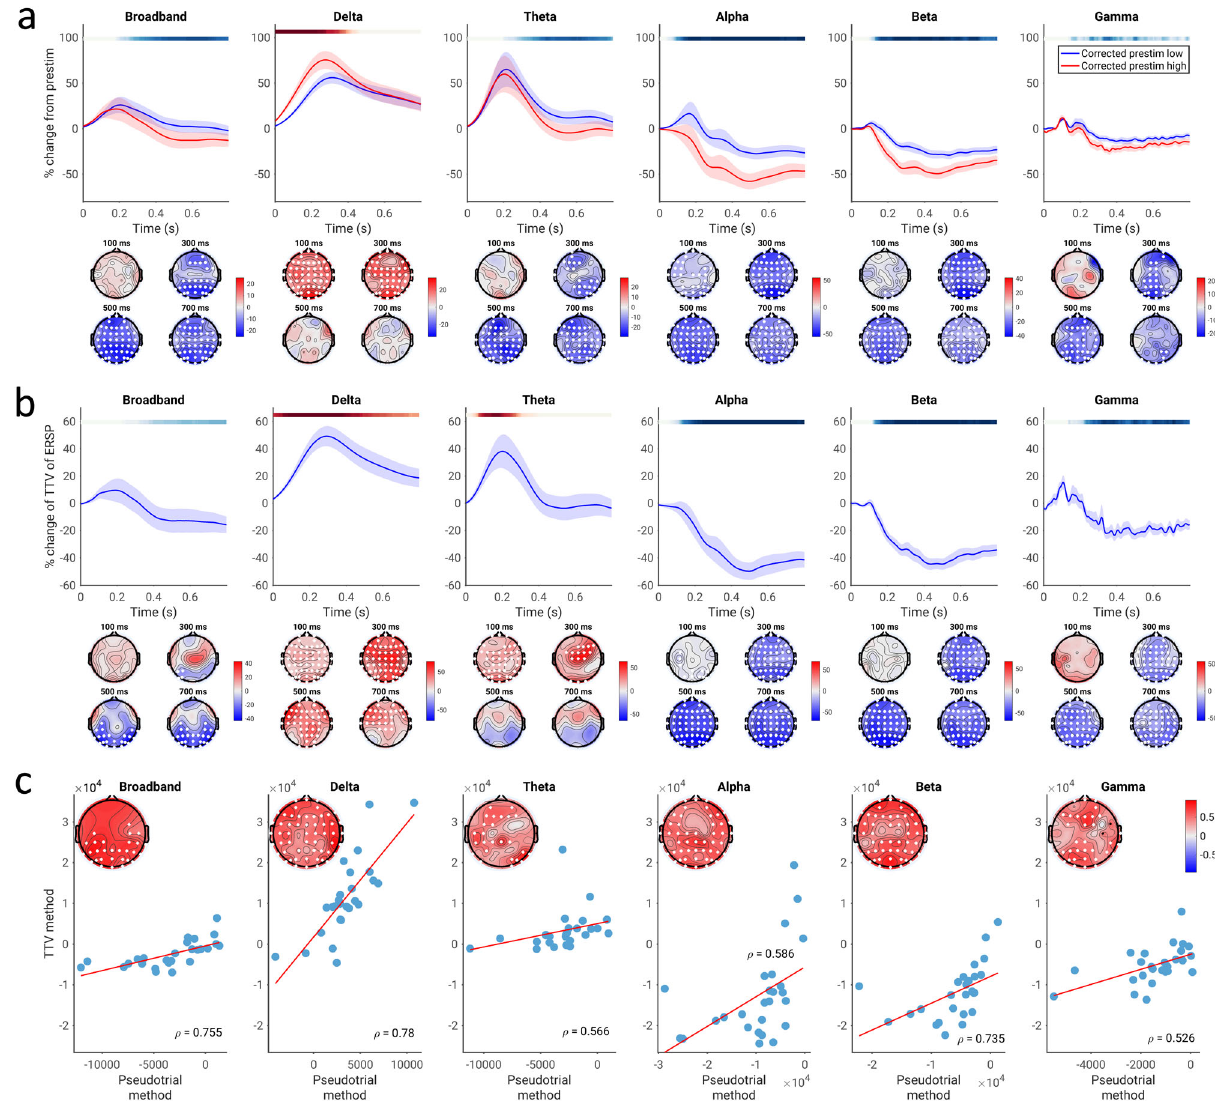
Fig. 6 Correlation of spontaneous and evoked spectral power in the replication EEG dataset (equivalent to Fig. 2 for the main dataset). a Pseudotrial- corrected time courses for high prestimulus (red) and low prestimulus (blue) conditions. Line shows mean across all sensors and subjects, shaded area indicates standard error of the channel-average time course across subjects. Effect topographies are shown at 100 ms, 300 ms, 500 ms, and 700 ms; white dots indicate sensors which are part of a signi fi cant cluster. Shaded overbars indicate the signi fi cance of the difference between prestim high and low conditions. The shade of the bar indicates the percent of sensors which are part of a signi fi cant cluster at any given time point (i.e., darkest = all sensors part of cluster, lightest/white = no sensors part of cluster); red indicates positive clusters (prestim high > prestim low), blue indicates negative clusters. b Time course of TTV in each frequency band, expressed in terms of percent change from prestimulus levels. Lines, overbars, and topographies as in a : red overbars indicate clusters with TTV increases, blue overbars indicate TTV decreases. c Across-subject correlation of the two methods. Scatter plots show the correlation of the mean values of the summary indices across all electrodes, while the topoplots show the correlations at each electrode, with white dots indicating signi fi cance following the cluster test. N = 22